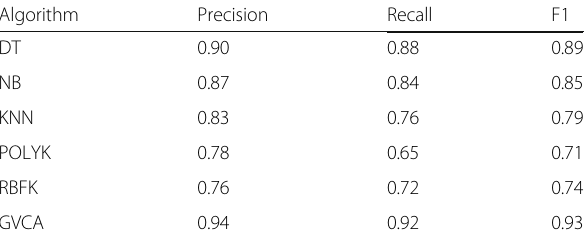
Table 10 Comparison of the classification performance on simulation dataset by the GVCA method and other classification algorithms Algorithm